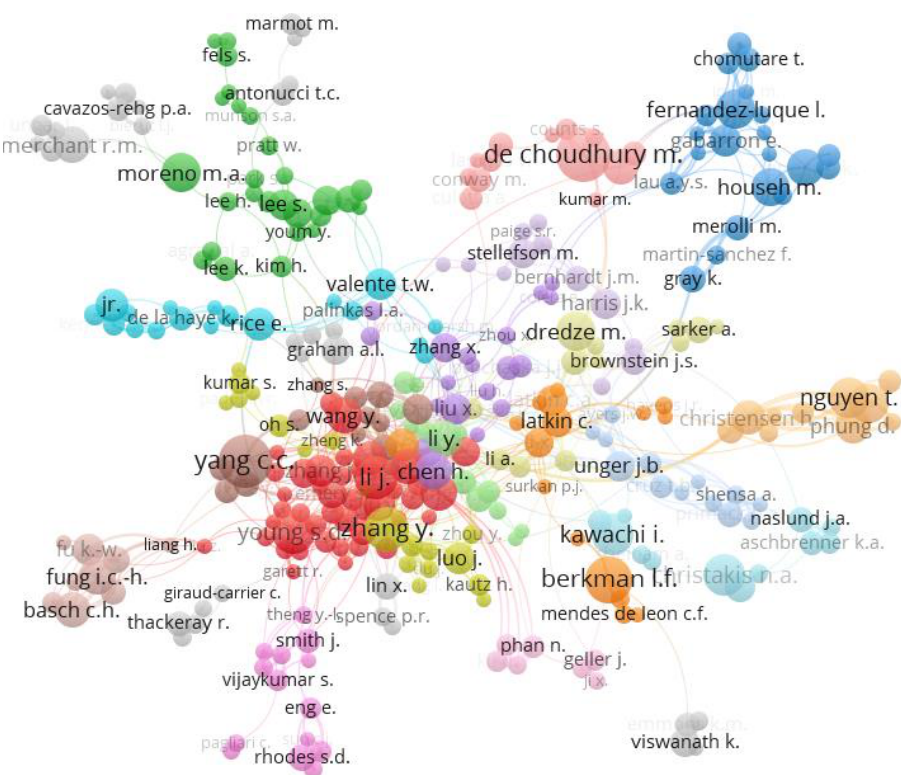
Figure 10. Scientific clusters of researchers focused on social networks in health.